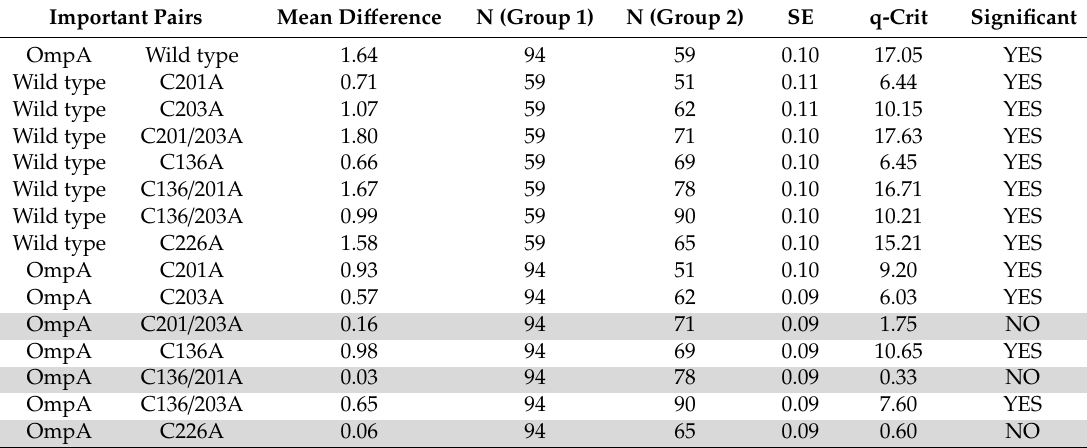
Table 2. Tukey post-hoc test to indicate where di ff erences between groups arise. Following the rejection of the null hypothesis with a one-way ANOVA, a Tukey post-hoc test for groups of di ff erent sizes was conducted. Clustering between OmpA and wild-type rMOMP was deemed to be significantly di ff erent, as well as clustering between wild-type rMOMP and every cysteine mutant, as assessed with q-crit values above 4.39, the q -value derived from a studentised q table with alpha as 0.05. Mean di ff erence refers to the di ff erence in clustering values in arbitrary units (AU); N to the number of cells analysed; SE, standard error. The mutants with the most significant decrease in clustering are highlighted in